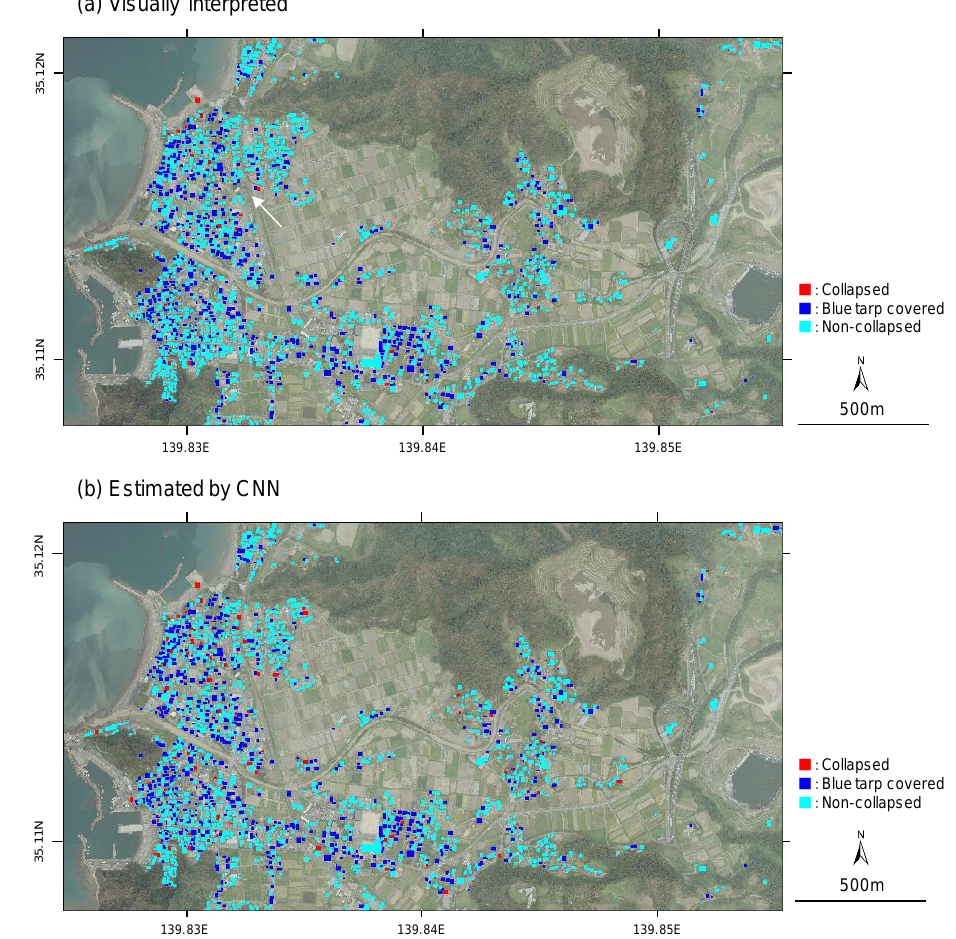
Figure 13. ( a ) Visually interpreted building damage in Kyonan town. The arrow indicates the approximate direction of the aerial photograph in Figure 12. ( b ) Building damage estimated by the proposed CNN model. Table 8. Classification accuracies of the building damage in Kyonan town. Visually interpreted